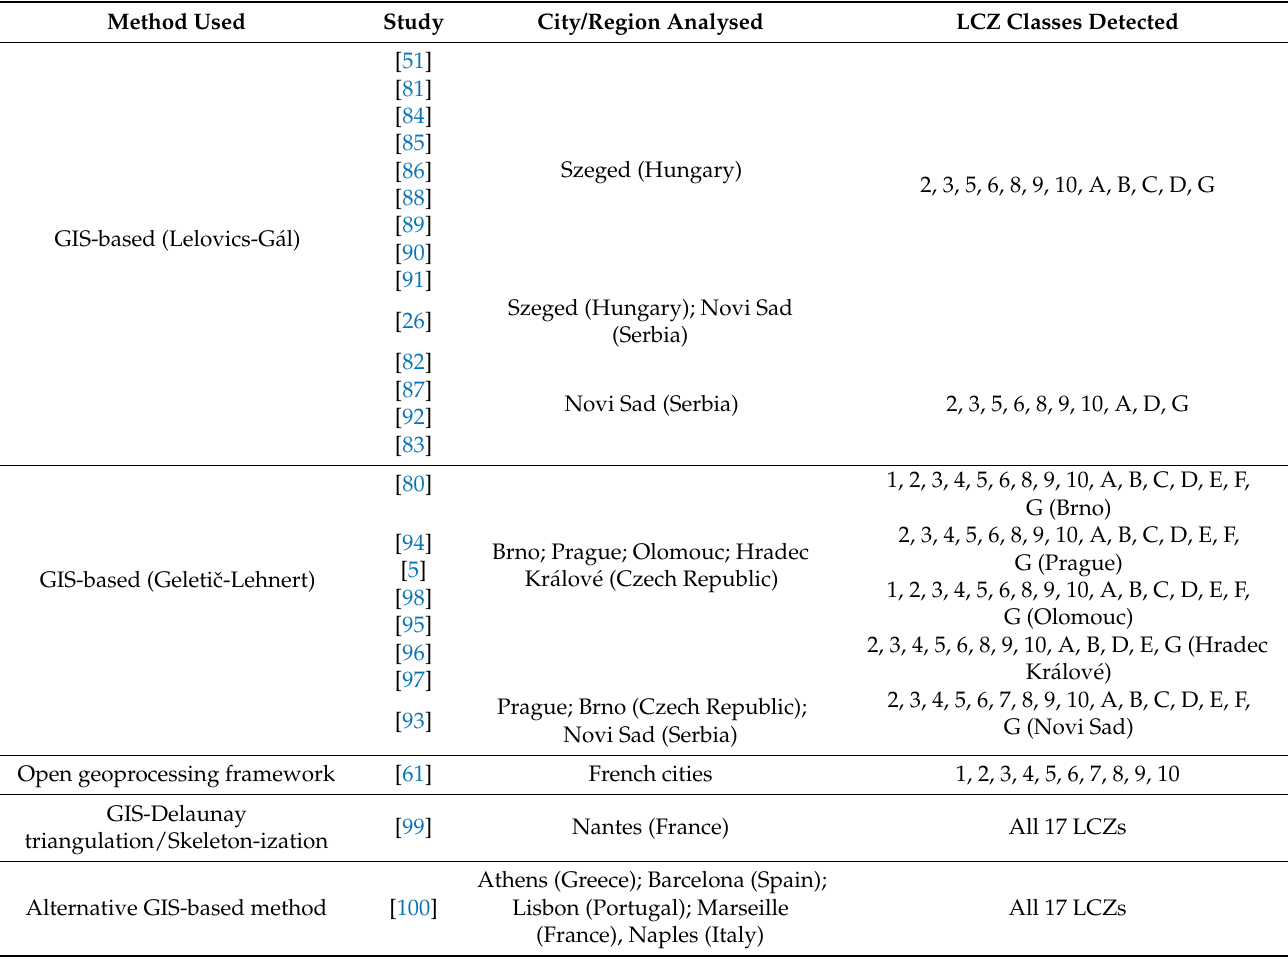
Table 2. GIS-based methods for LCZ mapping, as derived for the purposes of